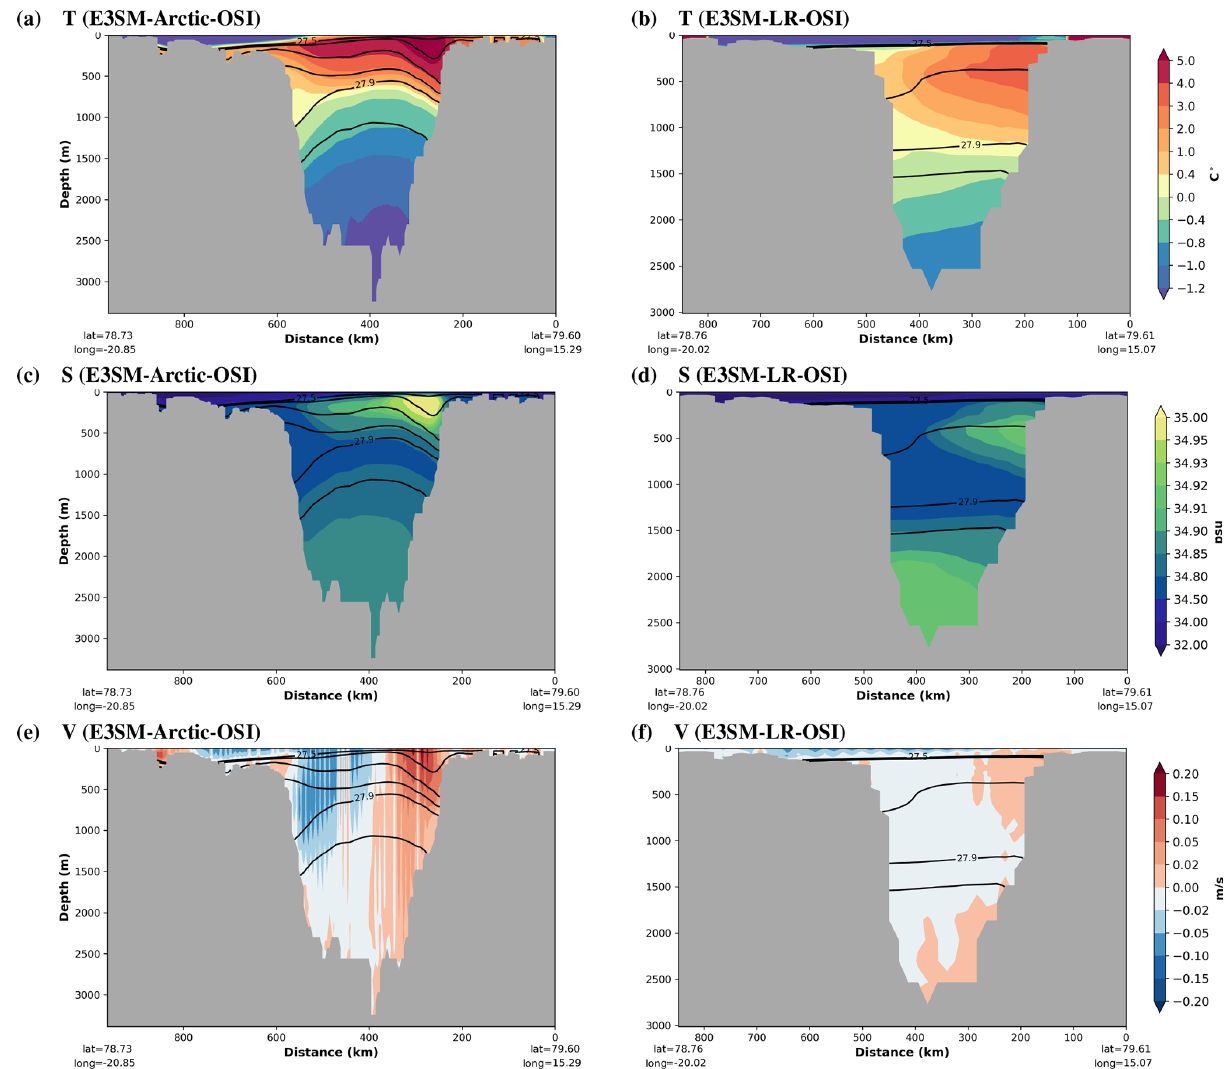
Figure 10. Cross section of (a, b) potential temperature, (c, d) salinity, and (e, f) normal velocity for the Fram Strait, for (a,c,e) E3SM- Arctic-OSI and (b, d, f) E3SM-LR-OSI (note that these fields are plotted on the native MPAS mesh, identifying the mesh cells that fall onto the specific transect; this is the reason for the noisy velocity values in panels e, f ). Annual climatologies are computed over years 166–177. Black contours show potential density